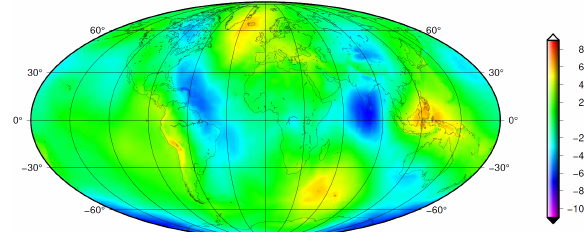
Fig. 2. Geoidal heights (in meters) of model GOCO06s with respect to the computed triaxial ellipsoid of case G-T6 in Mollweide projec- tion. mean = 0.000001 m, min = −71.96 m, max = 70.29 m, rms = 24.70 m.